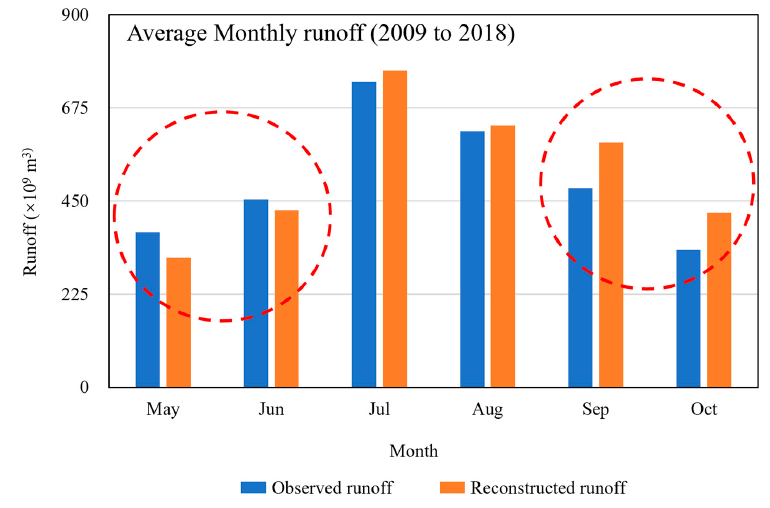
Figure 17. Average monthly runoff during flood season after the full operation of the TGD.